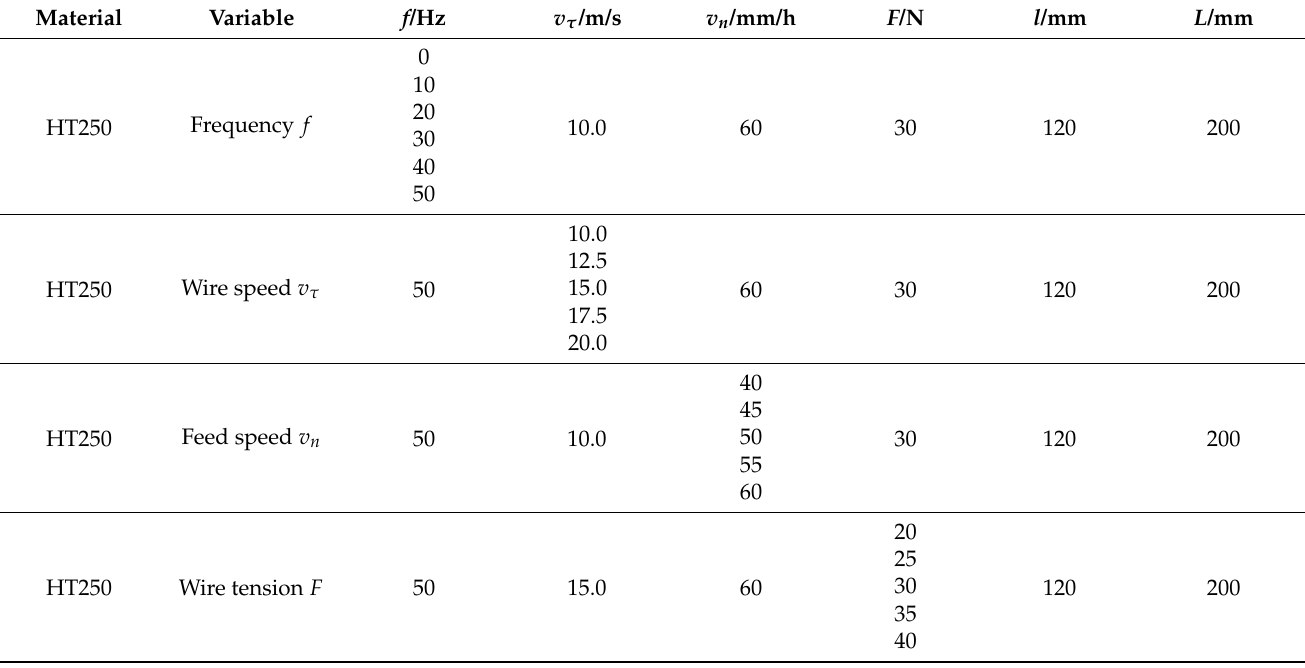
Table 2. Experimental design of sawing force